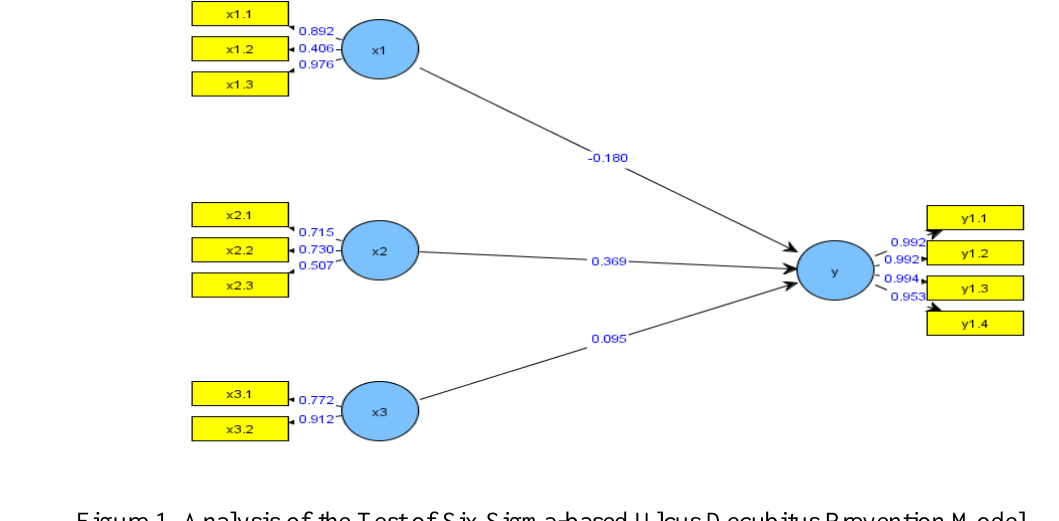
Figure 1. Analysis of the Test of Six Sigma-based Ulcus Decubitus Prevention